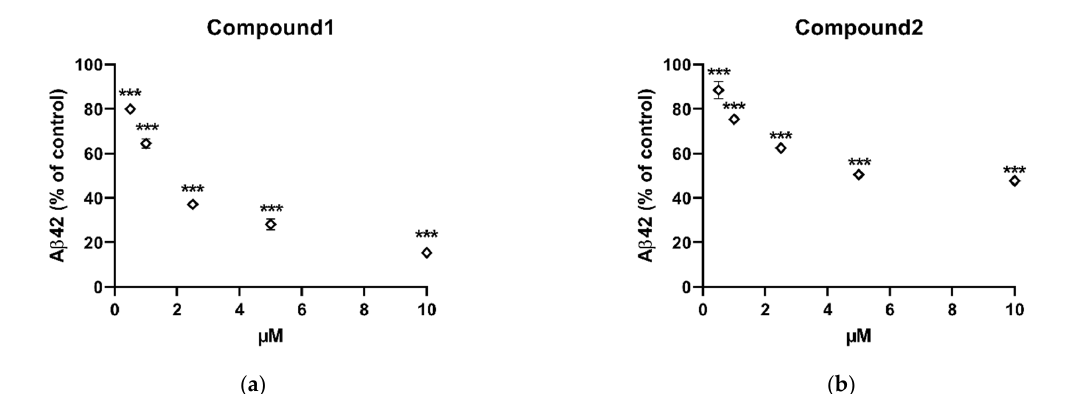
Figure 5. Changes in the level of A β 42, following exposure to ( a ) compound 1 and ( b ) compound 2 in vitro. Cells were incubated with indicated concentrations of compounds for 8 h. Statistically significant differences in % of inhibition values are indicated (*** p < 0.001, one-way ANOVA). Data are presented as mean ± SEM ( n = 4). DMSO served as negative control.